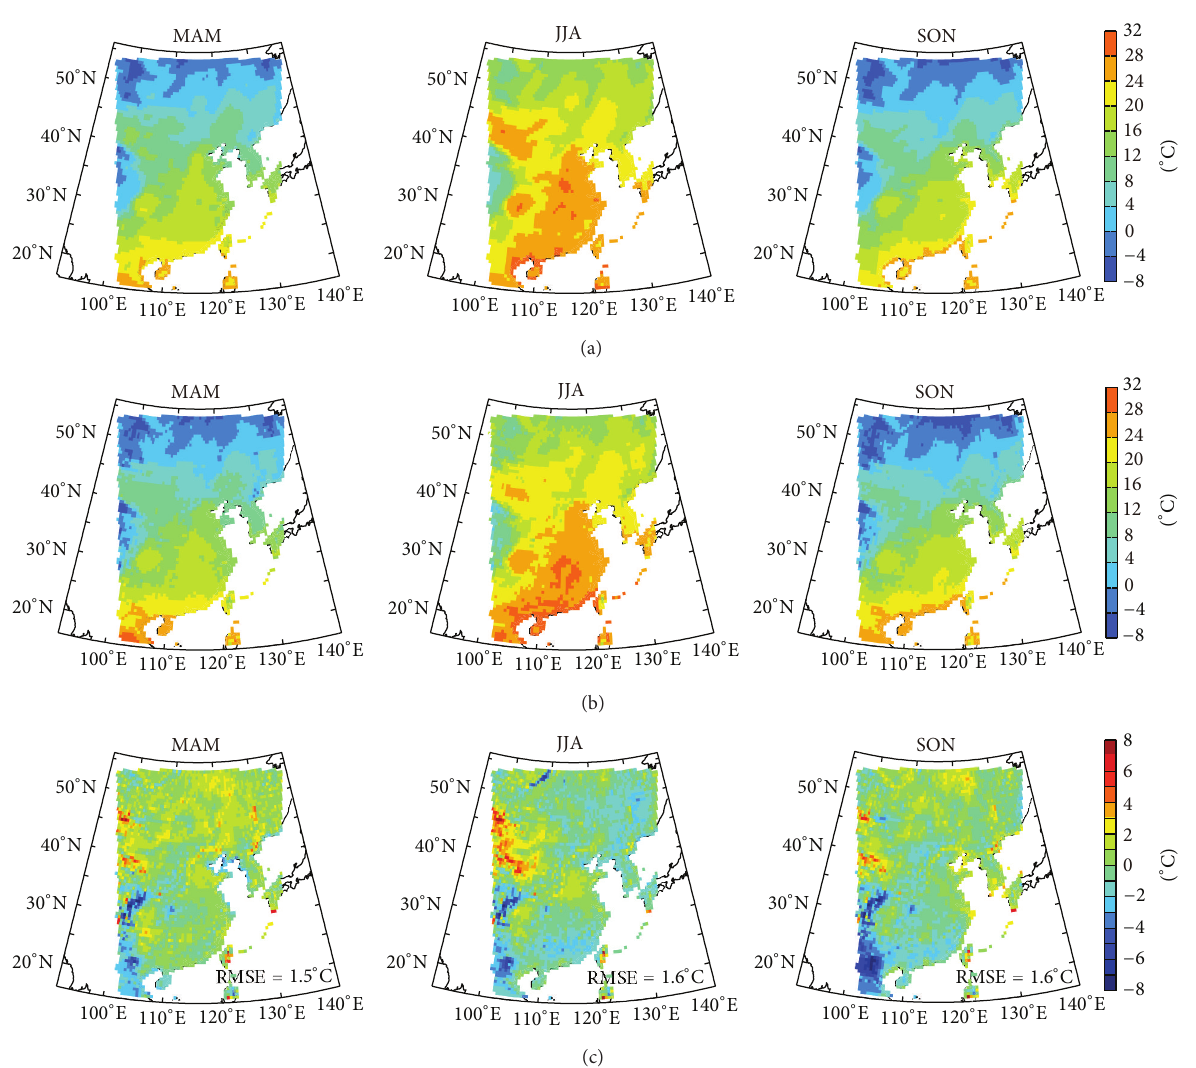
Figure 3: Simulated (a) and observed (b) average air temperature 2 m above ground from 2002 to 2009 and the differences from simulation minus observation (c) ( RMSE denotes root mean of square errors between simulation and observation) for spring (March to May; MAM), summer (June to August; JJA), and autumn (September to November; SON).